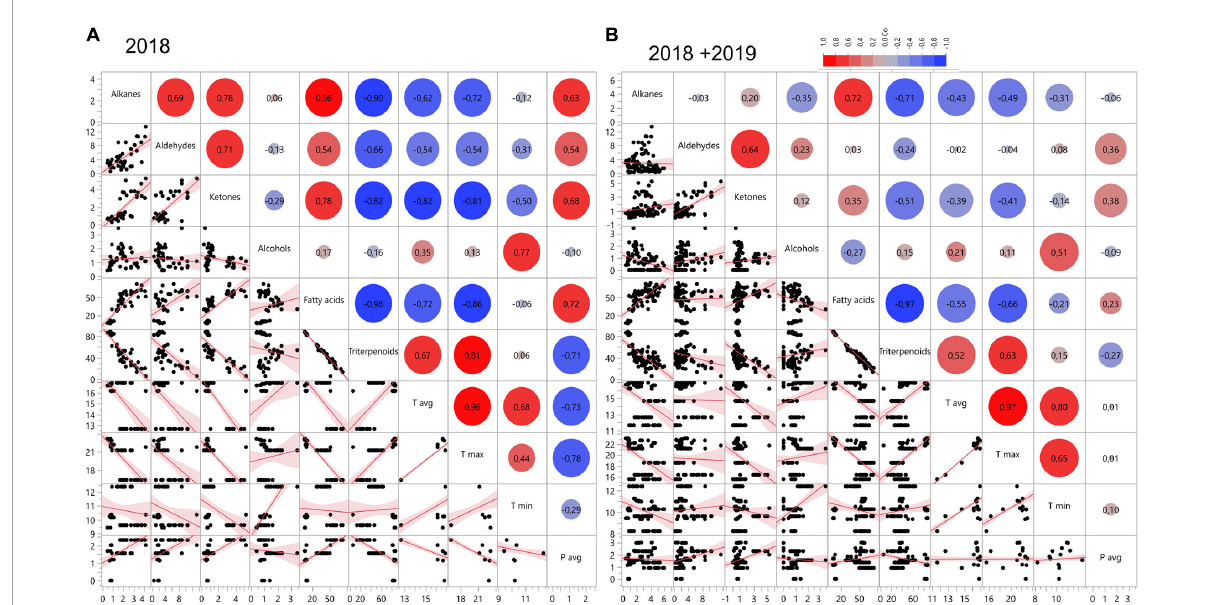
FIGURE3 Correlation matrix showing relationship between wax compounds and climatic factors averaged through 8 weeks pre-harvest in (A) 2018 and (B) 2018 and 2019. X and Y axis in the correlation matrix can represent either the relative amount of each of the respective groups of compounds, ◦ C in the case of temperature (T avg , T max , T min ) or mm for precipitation (P avg ).